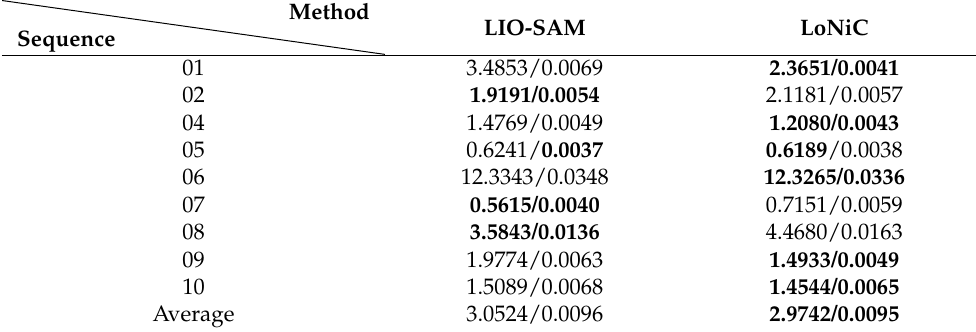
Table 3. Relative pose error of LIO-SAM and LONIC on the KITTI dataset.